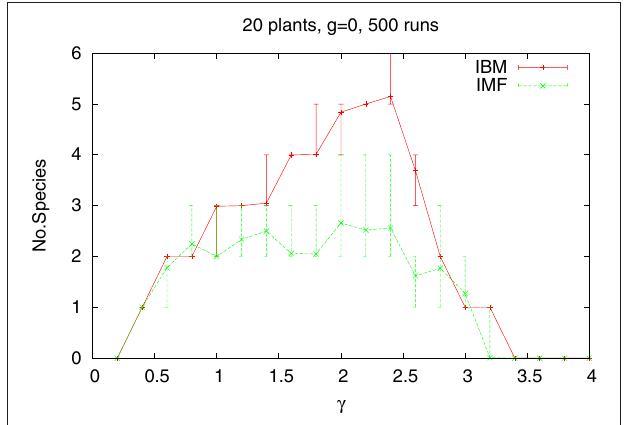
FIGURE 3 | Same as above, but for heterogeneous habitat. Gradient of steepness 0.5. The vertical lines indicates the statistical error